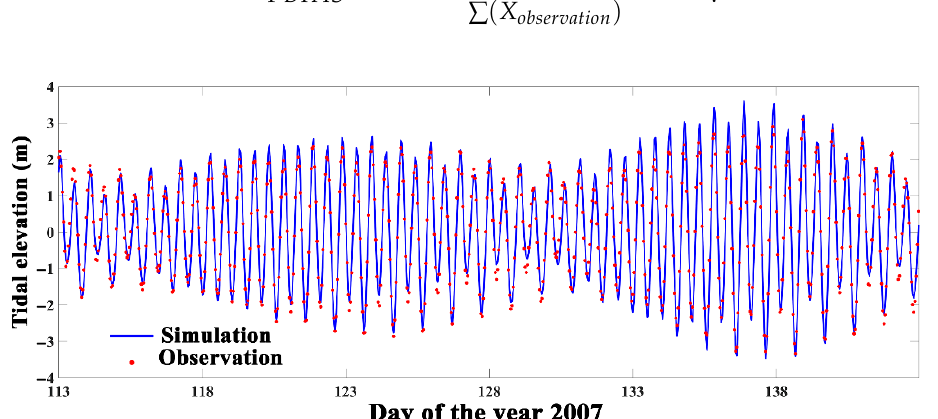
Water 2021 , 13 , x FOR PEER REVIEW Figure 3. Observed (dot red line) and simulated (solid blue line) tidal elevation at the T1 station.